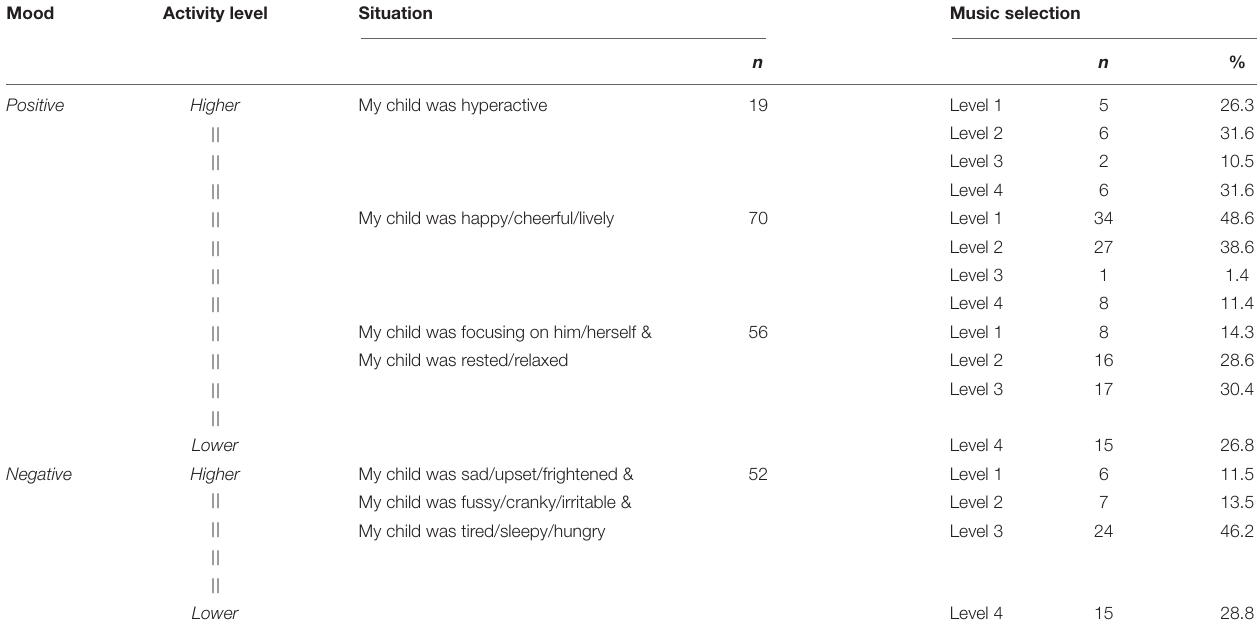
TABLE 4 | Situations and mothers’ repertoire